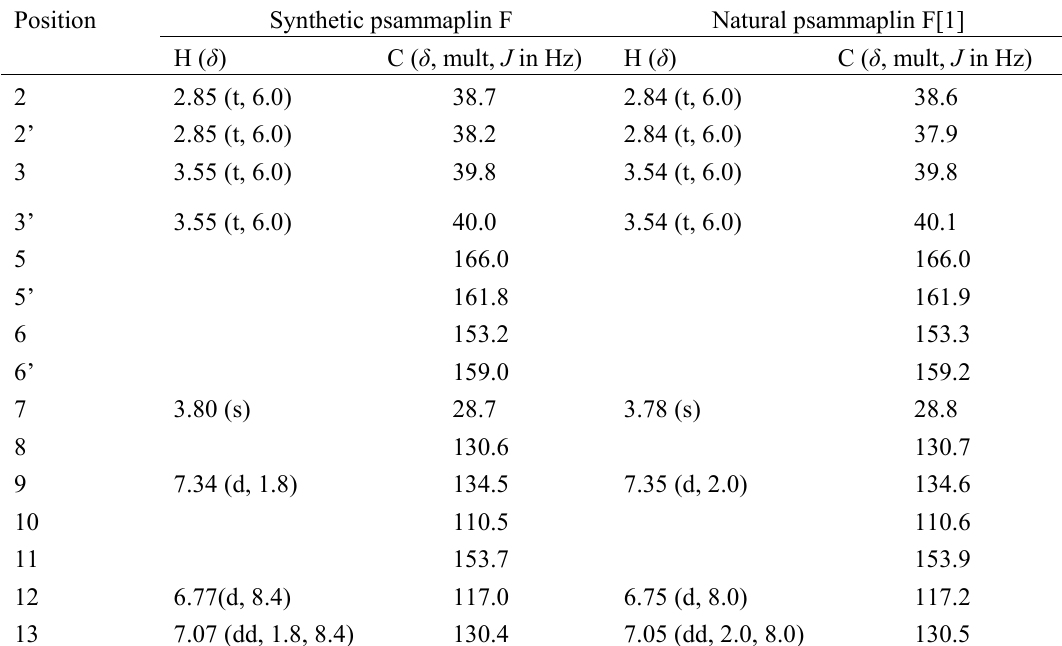
Table 1. Comparison of 1 H-NMR (600 MHz) and 13 C-NMR (150 MHz) data in CD synthetic and natural psammalin F ( 1 ).